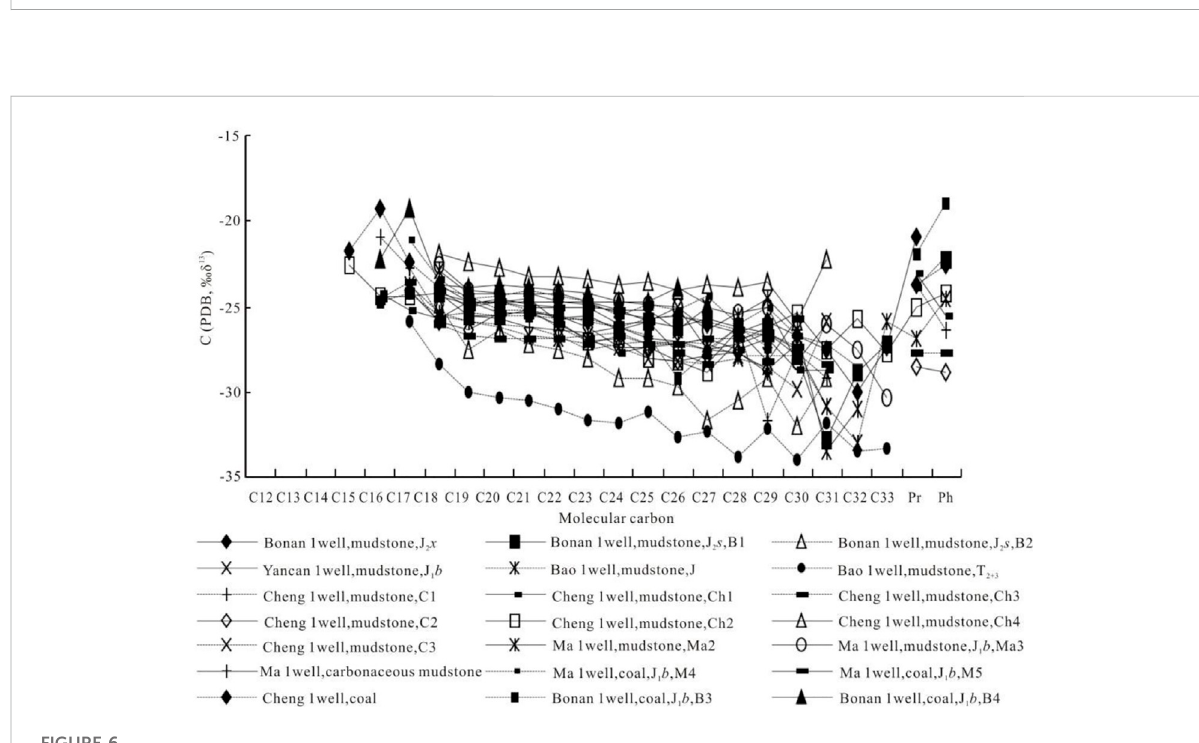
FIGURE 6 Distribution characteristics of molecular carbon isotopes in the J-T source rocks in the study